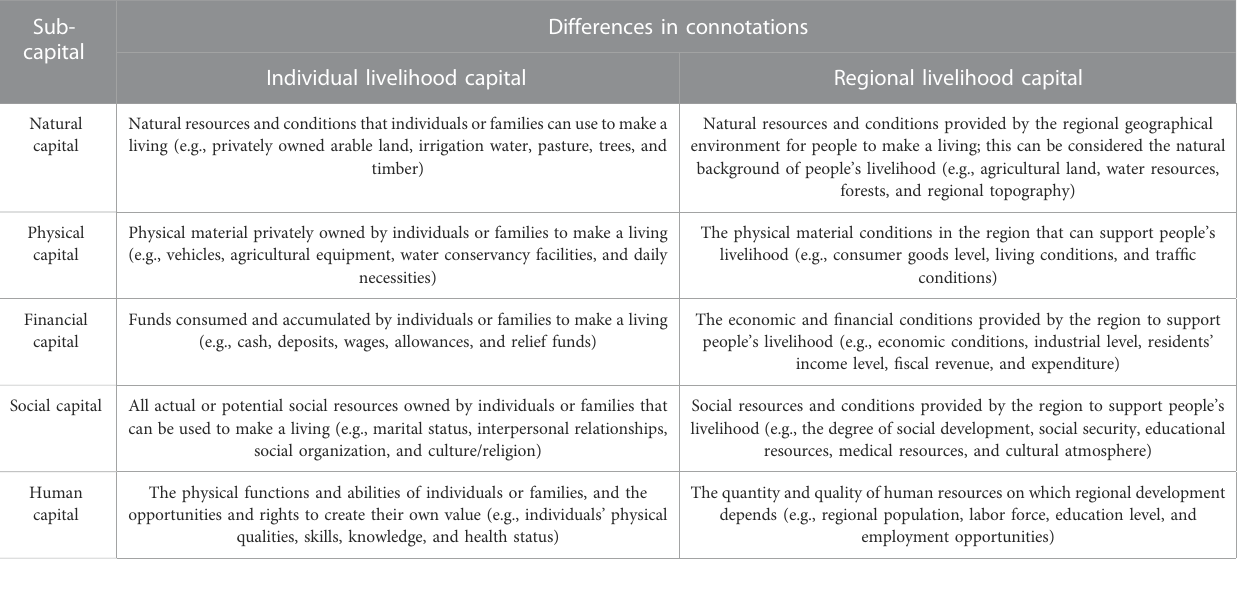
TABLE 1 Differences between individual livelihood capital and regional livelihood capital.